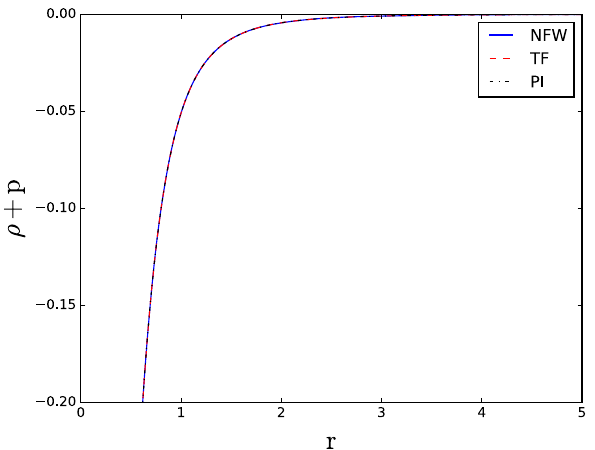
Fig. 3 The dark matter density ρ as a function of the radial distance r with different wormhole’s spins a for the NFW profile. The modeling parameters are θ = π/ 2, ω = − 0 . 33, R s = 10 10 , r 0 = 1 and ρ s = 5 × 10 − 3